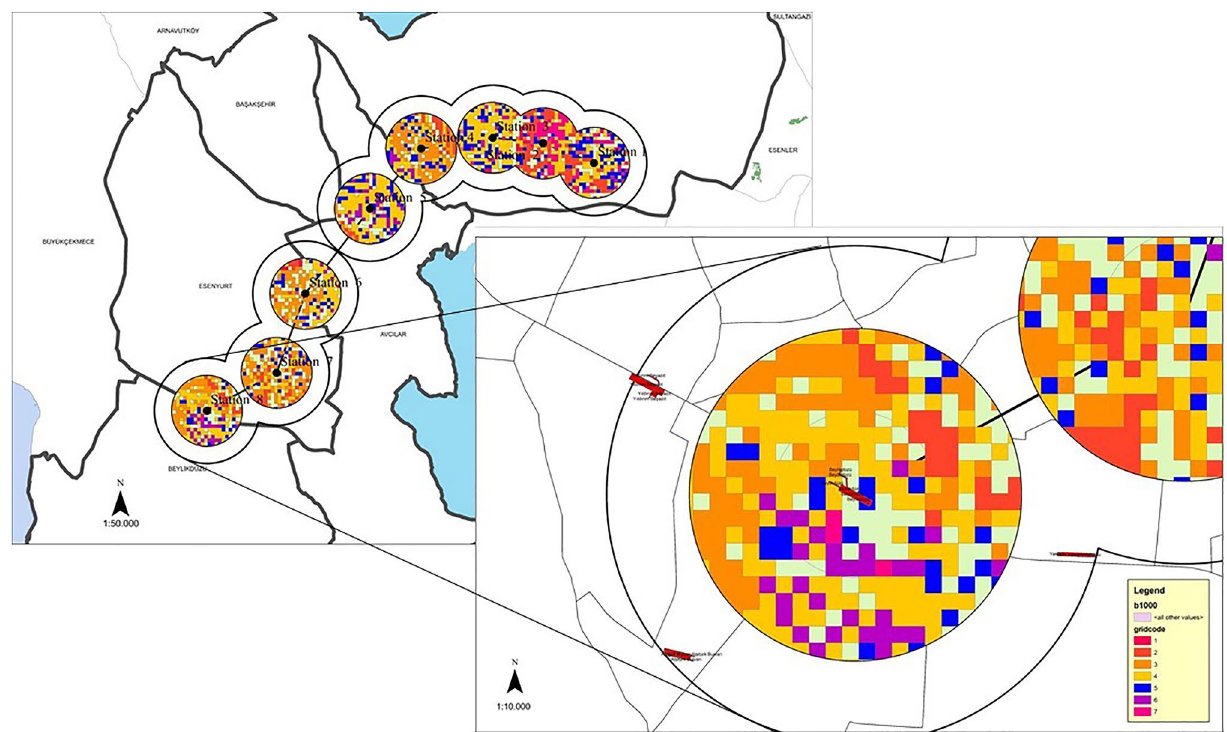
Fig. 8 1000 m station buffer analysis (illustrated by